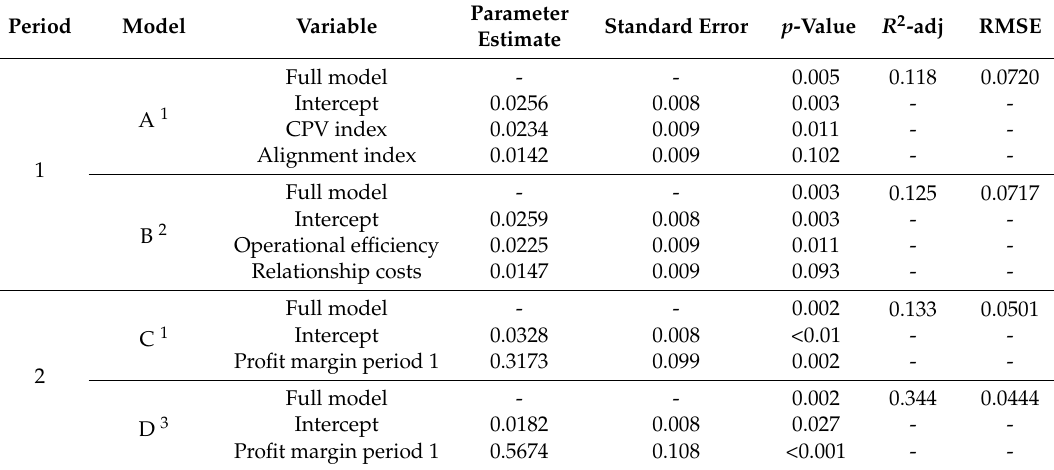
Table 8. Models explaining observed variation in contractor net profit